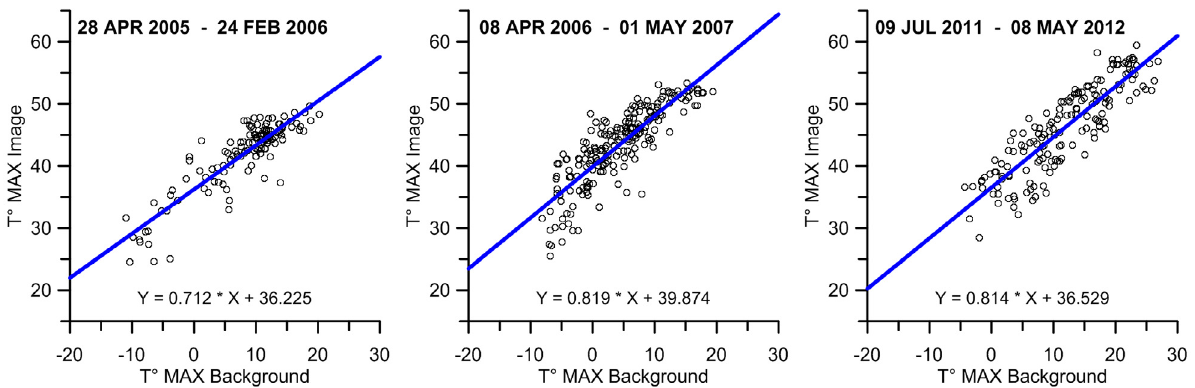
) and the maximum temperature value S